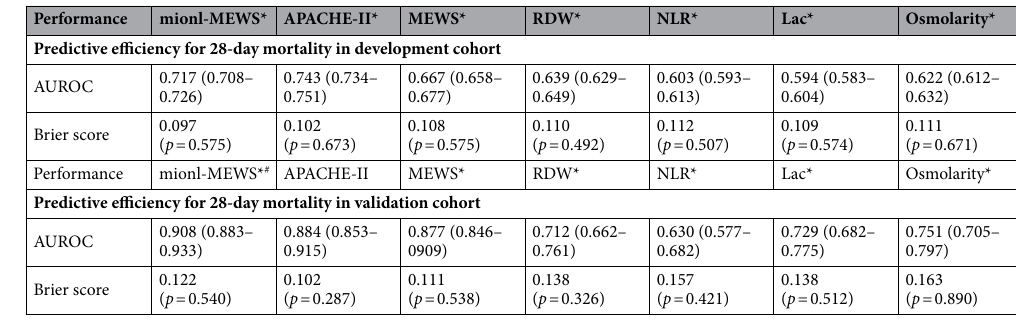
Table 8. Performance of mionl-MEWS, APACHE-II, MEWS, RDW, NLR, and lac for predicting 28 day- mortality in critically ill patients in the development and validation cohorts. *mionl-MEWS versus APACHE-II or MEWS or RDW or NLR or Lac or Osmolarity (p < 0.001). # mionl-MEWS versus APACHE-II ( p = 0.120), *mionl-MEWS versus MEWS or RDW or NLR or Lac or Osmolarity ( p <